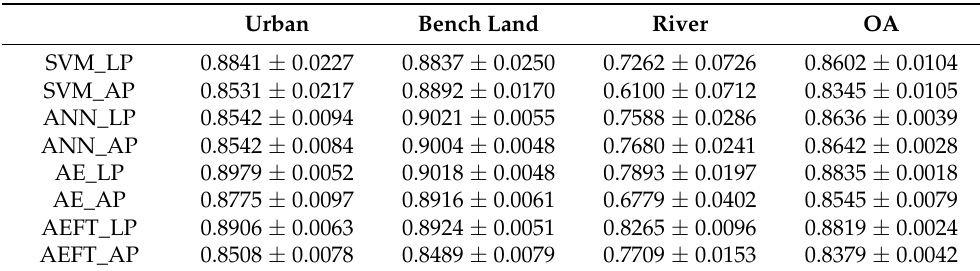
Table 13. Objective evaluation indicators of four classifiers on the learned parameters and all parameters of Touzi decomposition for Xi’an